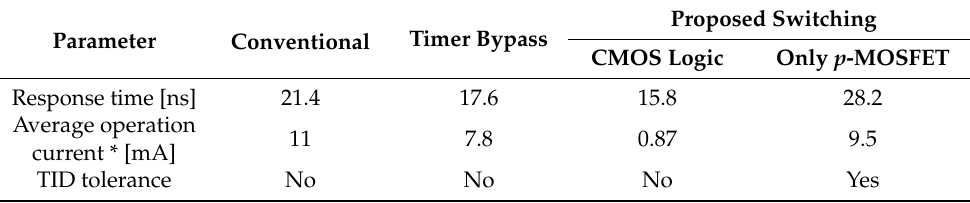
Table 1. Comparison of performances of pulsed-radiation detection circuits based on CMOS.